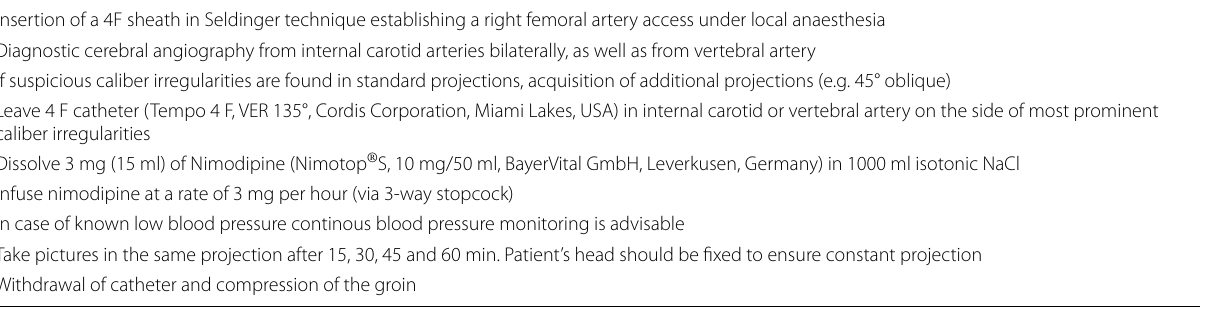
Table 2 Description of technique for angiographic nimodipine test Insertion of a 4F sheath in Seldinger technique establishing a right femoral artery access under local anaesthesia Diagnostic cerebral angiography from internal carotid arteries bilaterally, as well as from vertebral artery If suspicious caliber irregularities are found in standard projections, acquisition of additional projections (e.g. 45°